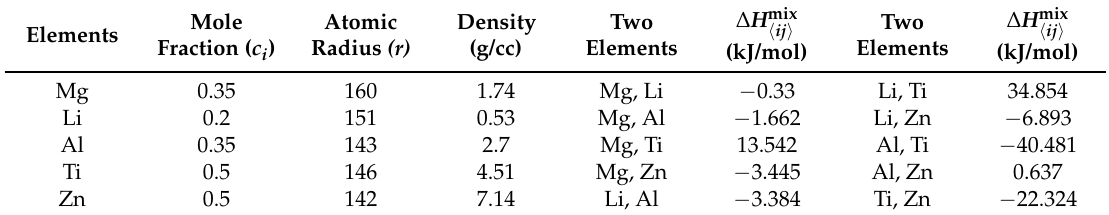
Table 1. Various thermodynamic and physical properties of different elements used in multi-component alloy.